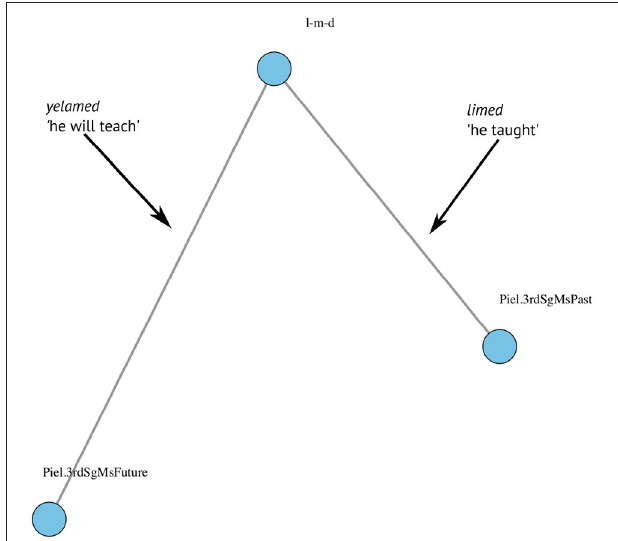
FIGURE 1 | A Hebrew morphological verb network: an illustration. The root l-m-d is linked to two binyan temporal-inflection patterns, yielding two